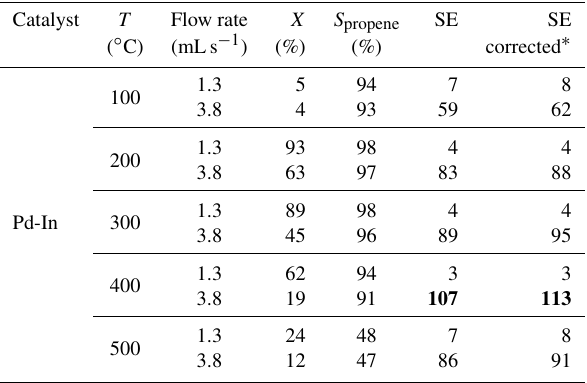
Table 3. Hydrogenation of propyne with parahydrogen over Pd-In / Al 2 O 3 catalyst: propyne conversion ( X ), selectivity to propene ( S propene ), and 1 H NMR signal enhancement (SE) factors for the CH proton of propene. The p -H 2 fraction was 87%. SE val- ues extrapolated to 90.5% p -H 2 fraction are provided in the “SE corrected” column. The largest SE values achieved are shown in